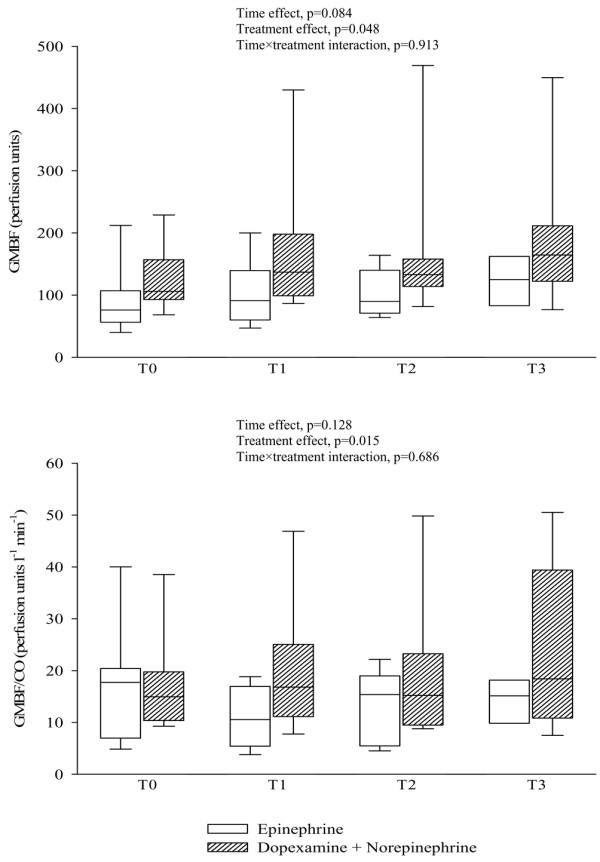
Evolution of gastric mucosal blood flow (GMBF) and ratio between GMBF and cardiac output. T0, just before catecholamine infusion; T1, as soon as mean arterial pressure reached 70 to 80 mmHg; T2, 2 hours after T1; T3, 6 hours after T1. Data are presented as boxplots. CO, cardiac output.